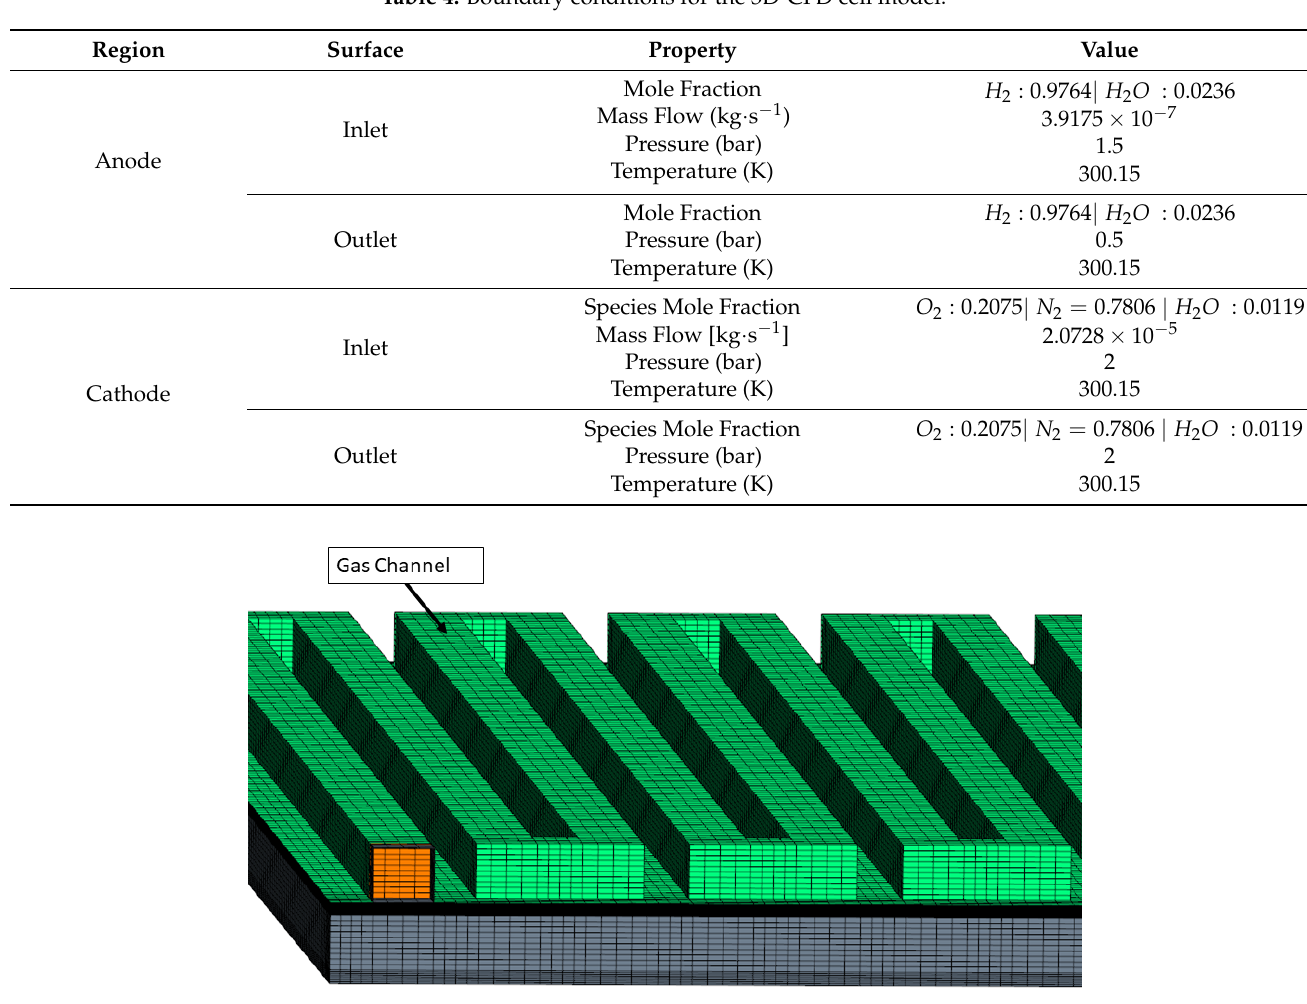
Table 4. Boundary conditions for the 3D-CFD cell model.